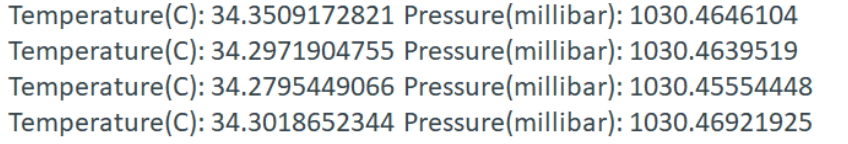
Figure 12. Results of the barometer test.